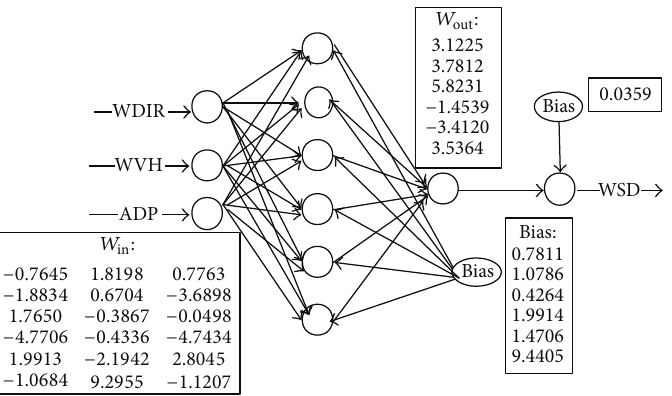
Figure 1: The structure of the ANN.